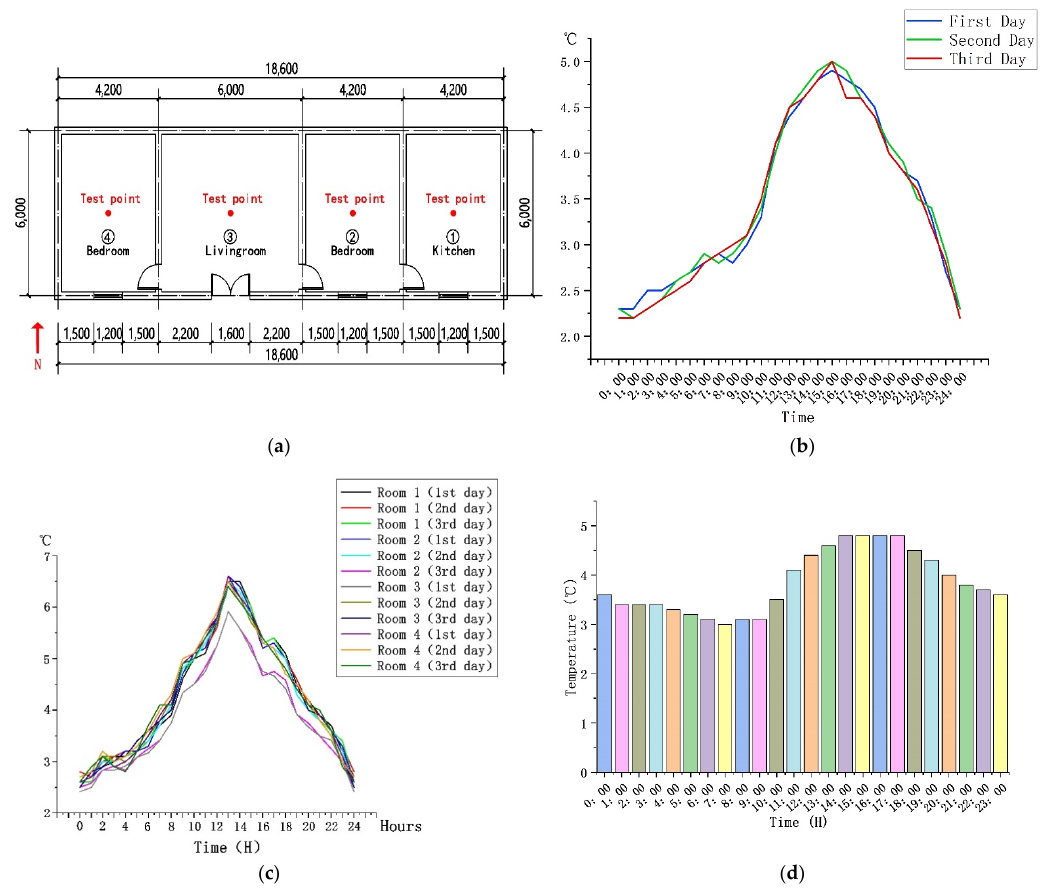
Figure 5. ( a ) Building layout. ( b ) Outdoor temperature distribution map. ( c ) Indoor temperature distribution map. ( d ) Outdoor temperature distribution during a day.